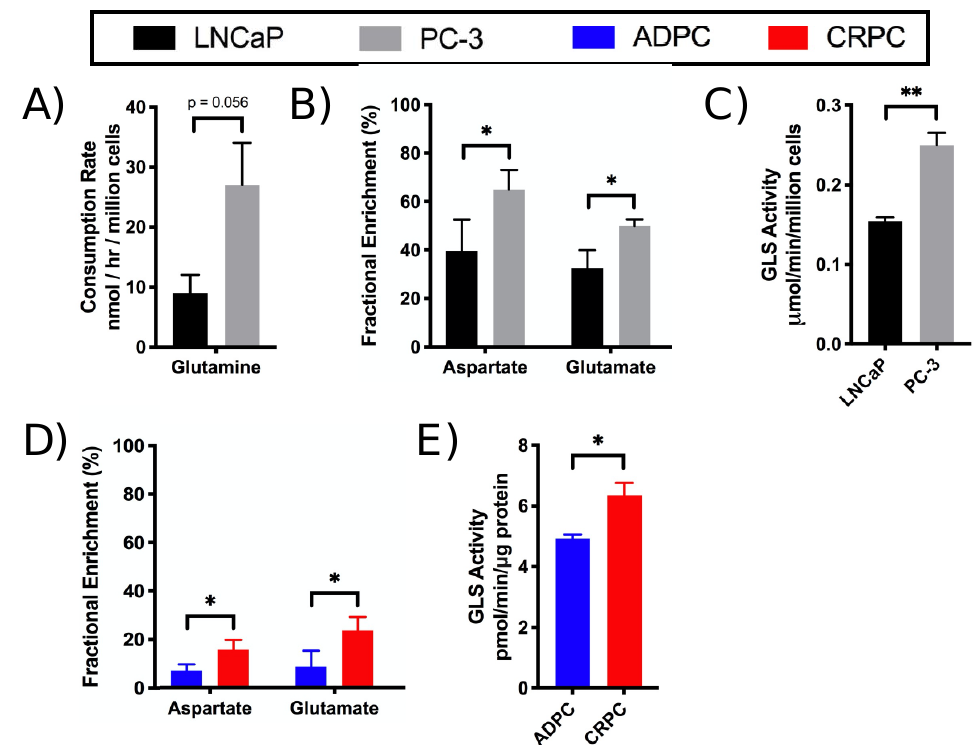
Figure 5. Glutamine metabolism through glutaminolysis and the TCA cycle is enhanced in CRPC. Glutamine metabolism was assessed in LNCaP and PC-3 cells based on ( A ) consumption rate of [U- 13 C]glutamine, ( B ) the fractional enrichment of aspartate and glutamate of cells labeled with [U- 13 C]glutamine, and ( C ) enzymatic activity of GLS. Flux through glutaminolysis and the TCA cycle was determined in ADPC and CRPC TRAMP tumors based on ( D ) the fractional enrichment of aspartate and glutamate of tumors labeled with [U- 13 C]glutamine and ( E ) enzymatic activity of GLS.(* p < 0.05, ** p < 0.01).